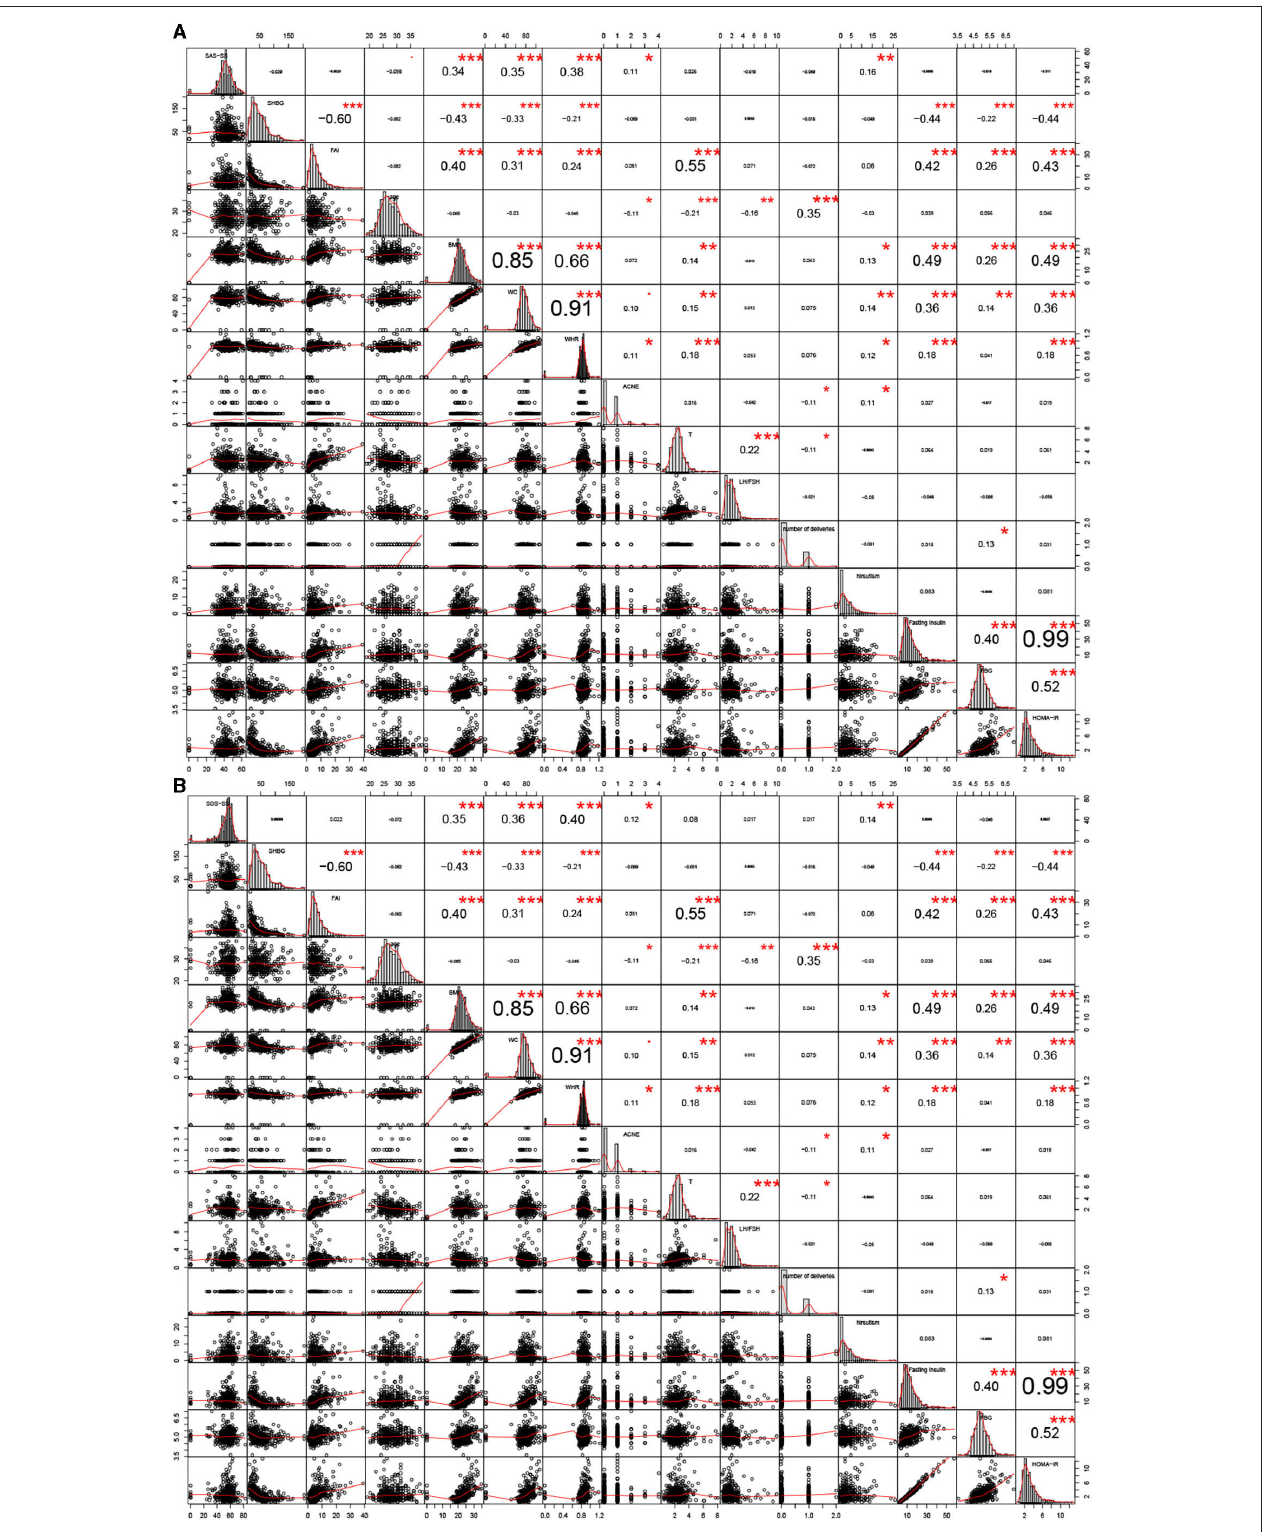
FIGURE 4 | Correlation analyses between anxiety/depression-like behaviors and the 14 clinical parameters in infertile group. * P < 0.05, ** P < 0.01, *** P < 0.005.